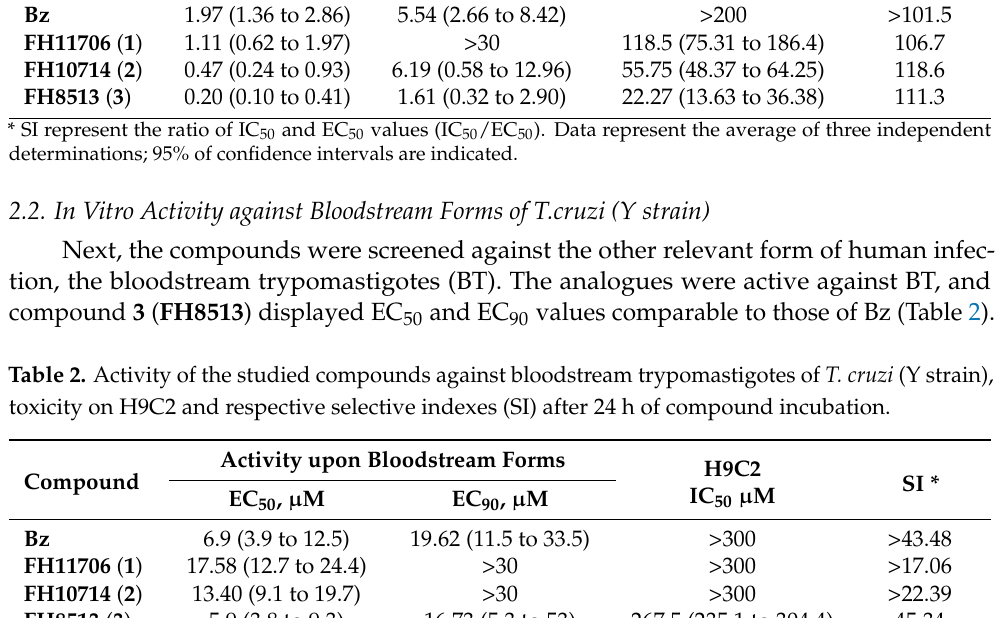
Table 1. Activity of the studied compounds against intracellular forms of T. cruzi (Tulahuen strain), toxicity on L929 cells and selective indexes (SI) after seven days of compound incubation. Compound